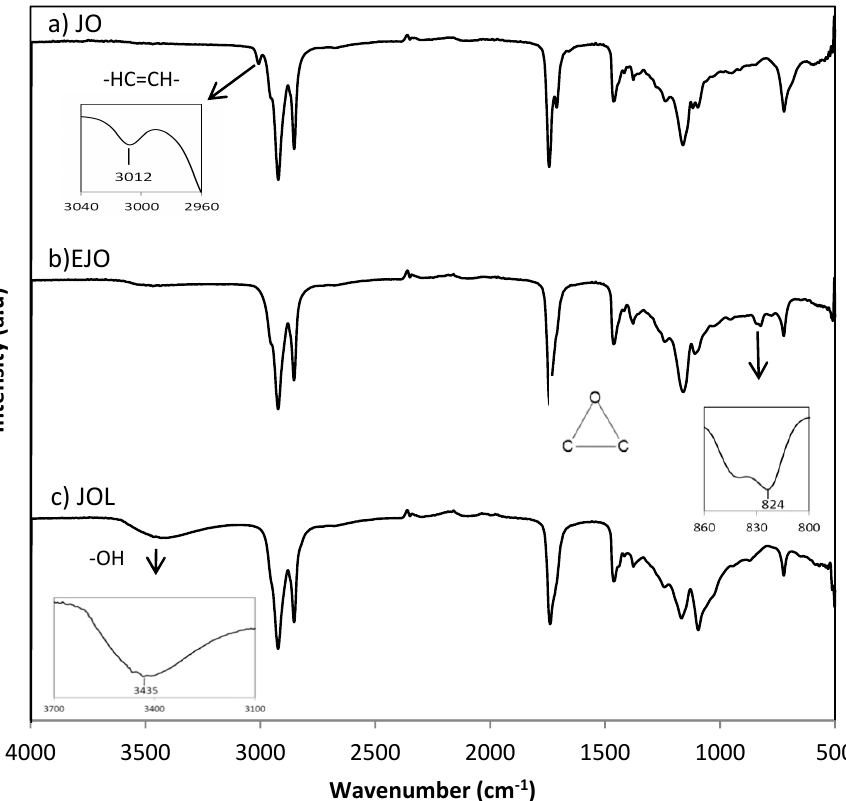
Figure 1. Fourier transform infra-red (FTIR) spectra during epoxidation and hydroxylation of jatropha oil.